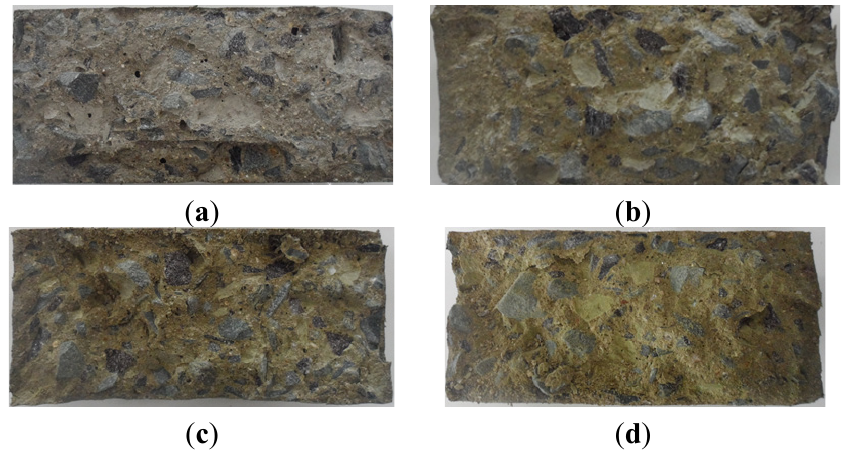
Figure 11. Fracture surfaces of ( a ) R40-CON; ( b ) R40-NS5; ( c ) R40-NS7.5; and ( d ) R40-NS10 cylinders after splitting test.